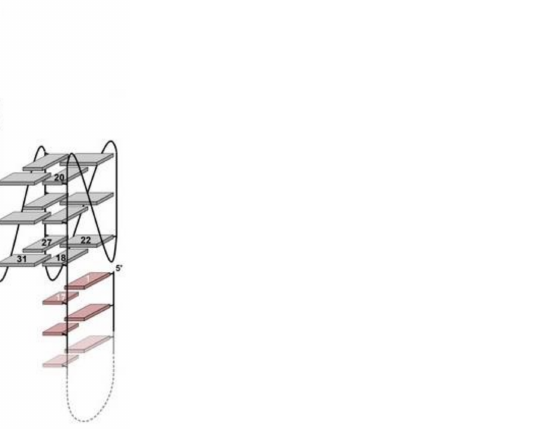
Figure 18. Schematic structure of Myc-dup3 ( A ) and Myc-dup5 ( B ) [69]. Reproduced under the Cre- ative Commons Attribution